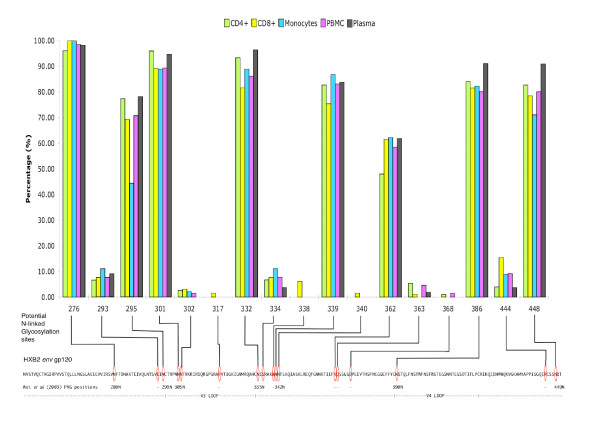
N-linked glycosylation frequency observed in the env gp120 C2-V5 region across plasma and cellular viral sequences. Frequency of HIV-1 N-linked glycosylation sites in plasma and diverse blood leukocyte populations. The X-axis represents the potential N-linked glycosylation sites identified in our study. The Y-axis shows the percentage frequency of the sequences for each compartment found with NLG at the relevant position. Below the bar chart is the env gp120 sequence of our reference HIV-1 HXB2 strain. Lines from the X-axis to the reference sequence illustrate where the observed NLG in our data would be on HXB2. NLG sites observed were matched with those reported by Wei et al [4] using the GenBank sequence U21135. The numbers below each red oval indicates where you might associate our NLG site with those from the study by Wei et al [4] in the GenBank sequence U21135. Positions with no visual correlation are indicated with a dash '-'.